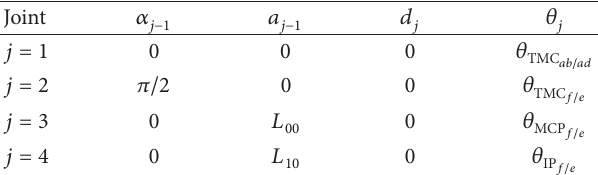
Table 8: Modified D–H parameters of the thumb.